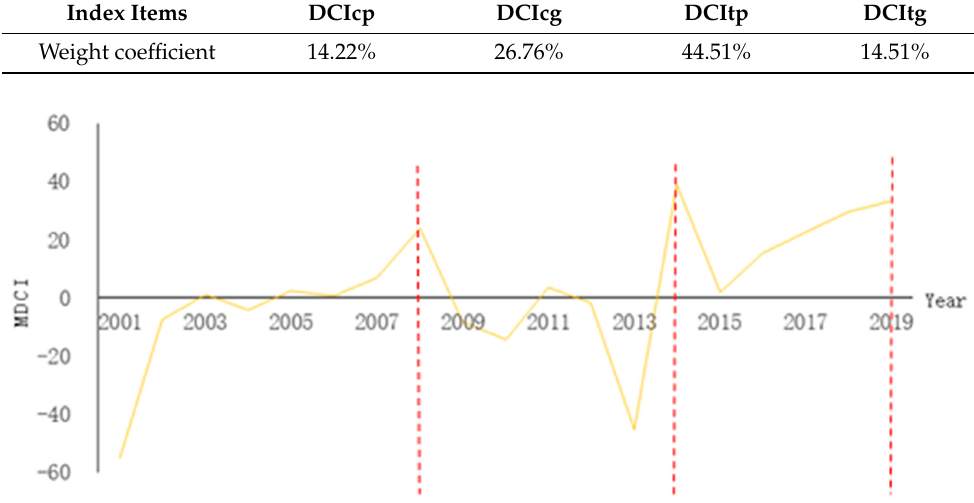
Figure 1. Variation curves of MDCI values in each year.